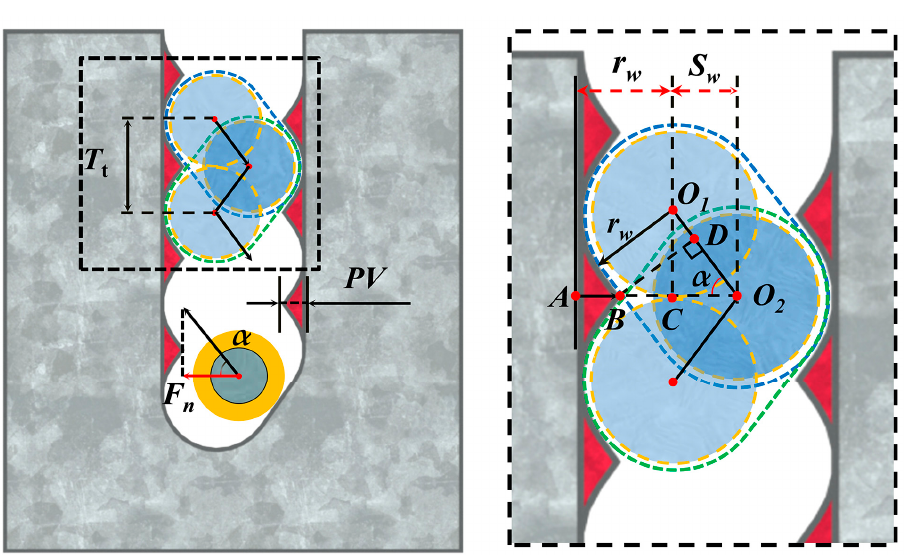
Figure 10. The formation process of periodic saw marks.